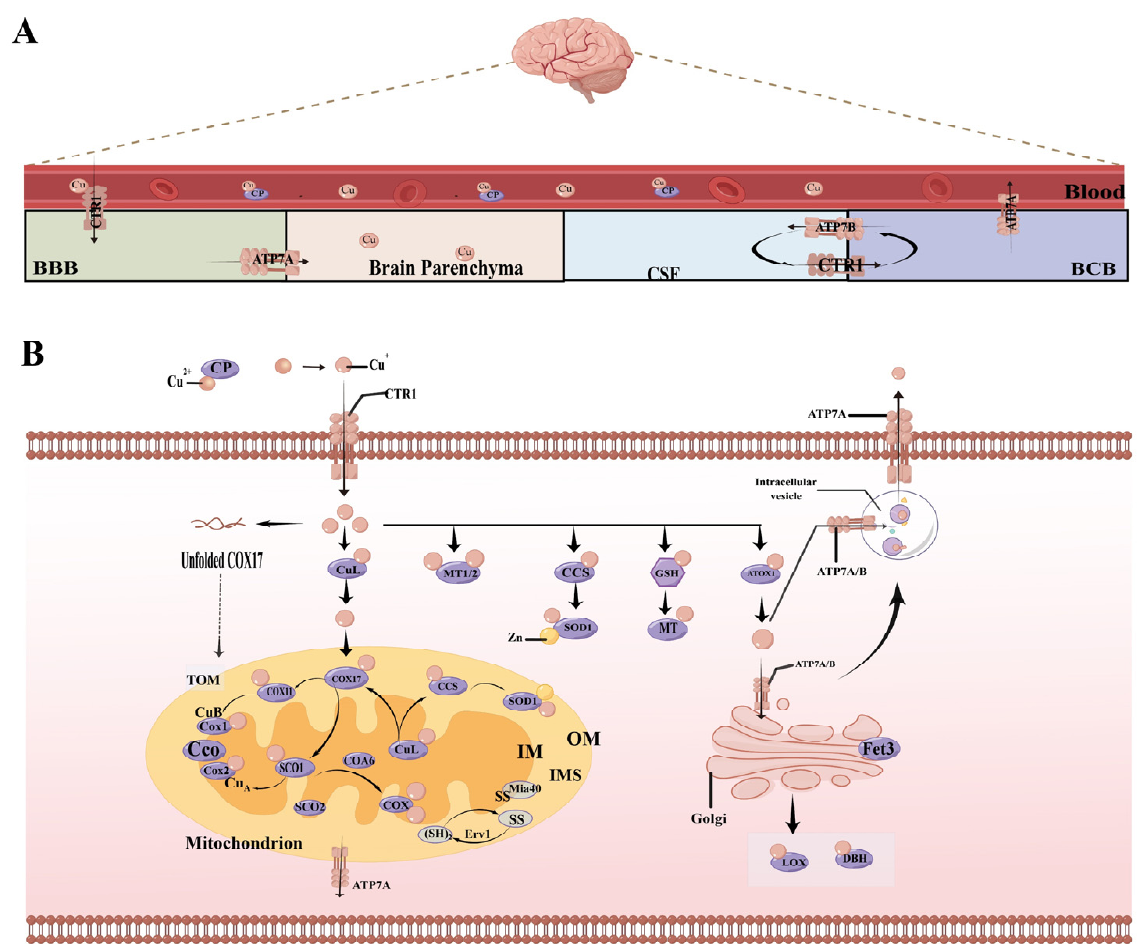
Figure 1. ( A ) The entry and exit of copper in the brain. Copper enters the brain through the